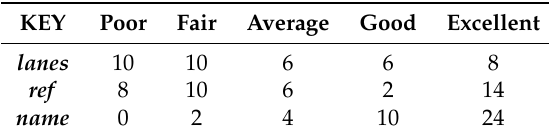
Table 10. Summary of compliance of all cities with suggested tag key combinations for the target tag highway=primary .